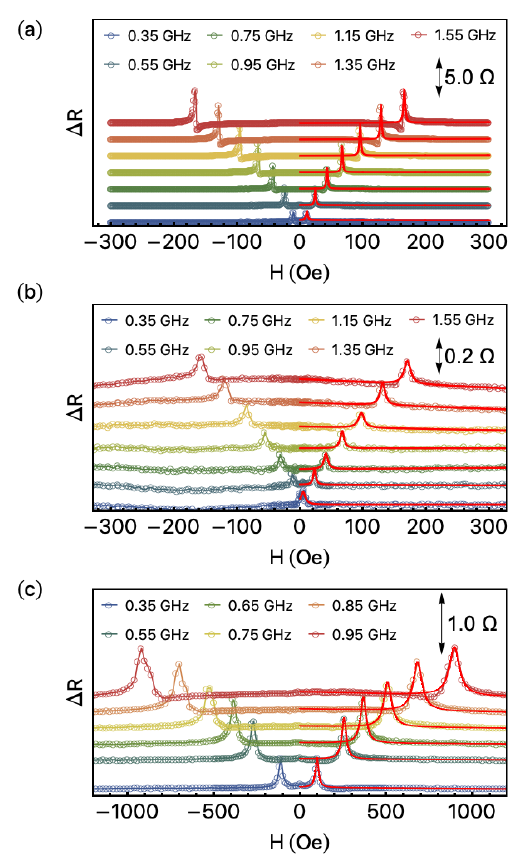
Figure 4. Variation of the real component of the impedance, ∆ R , as a function of the external magnetic field for selected frequency values. Response of the YIG/Pt-stripline system for the ( a ) LMI, ( b ) TMI, and ( c ) PMI configurations. The curves are shifted on a vertical scale in order to make the visualization clearer. The symbols correspond to the experimental data, while the red lines are the fit from which the resonance field H r and linewidth ∆ H are obtained. The arrows indicate the scales of each measured configuration with the appropriate